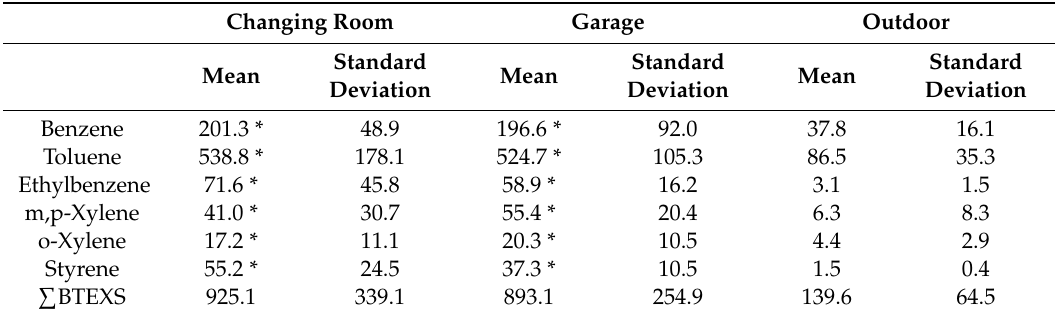
Table 2. Mean concentrations of benzene, toluene, ethylbenzene, xylene, and styrene (BTEXS) ( μ g/m 3 ) in the changing room, in the garage, and outside the fire station in Poland.